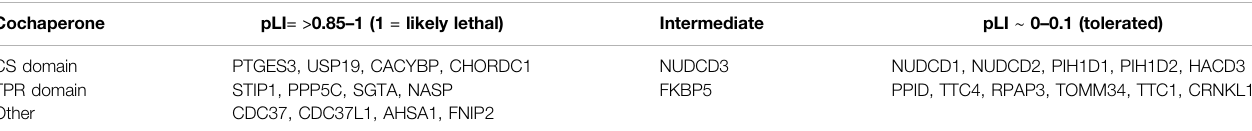
TABLE 3 | Hsp90 cochaperones without known genomic mutations linked to disease. pLI (probably of loss interference) numbers are from https://gnomad. broadinstitute.org/. Cochaperone pLI = > 0.85 – 1 (1 = likely